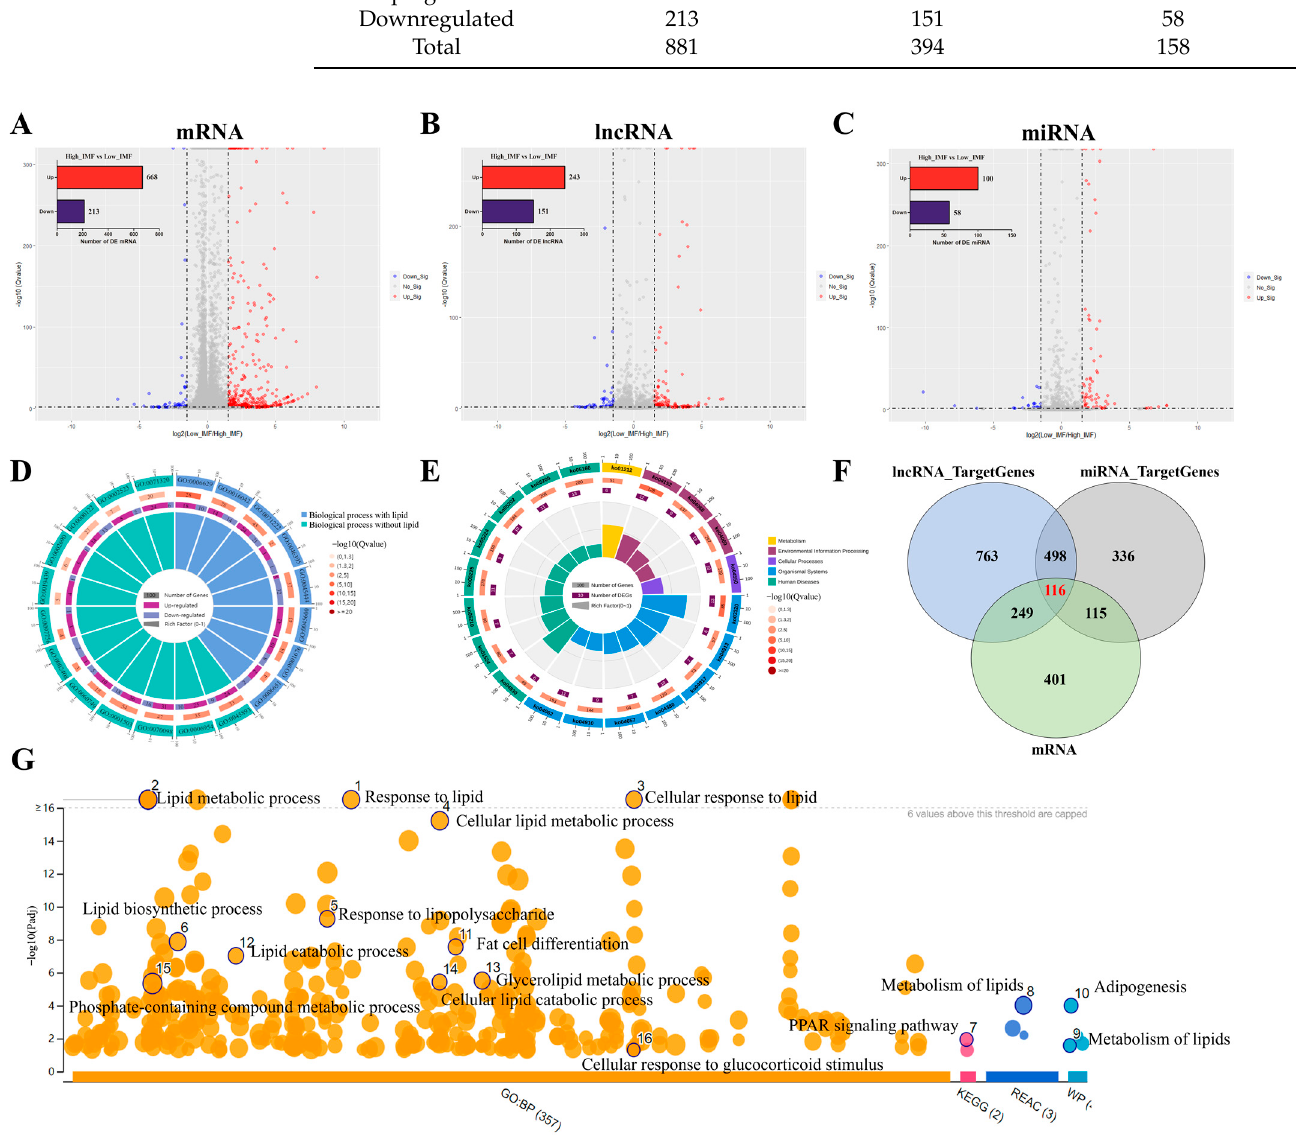
Figure 2. Differential expression of mRNAs, miRNAs, and lncRNAs between high and low IMF in crossbred pigs (Berkshire × AQSW). Volcano plots for the mRNAs ( A ), miRNAs ( B ) and lncRNAs ( C ) with up-regulated and down-regulated expressions between high and low IMF in crossbred pigs (Berkshire × AQSW). ( D ) GO enrichment analysis for DE mRNAs. ( E ) KEGG enrichment analysis for DE mRNAs. ( F ) Venn diagram of candidate target genes of DE mRNA, DE miRNA and DE lncRNA between high and low IMF. ( G ) Top 20 terms of GO and KEGG enrichment in 116 overlapped target